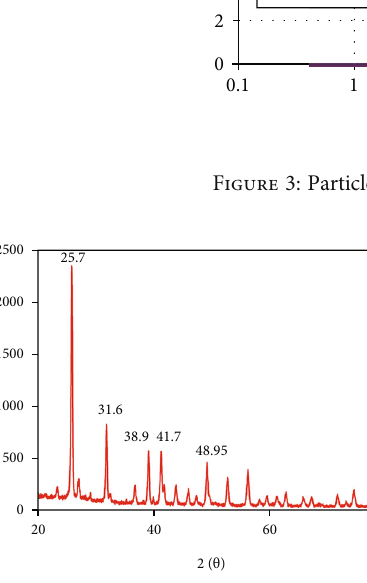
Figure 4: XRD di ff ractogram of calcium-rich zeolite